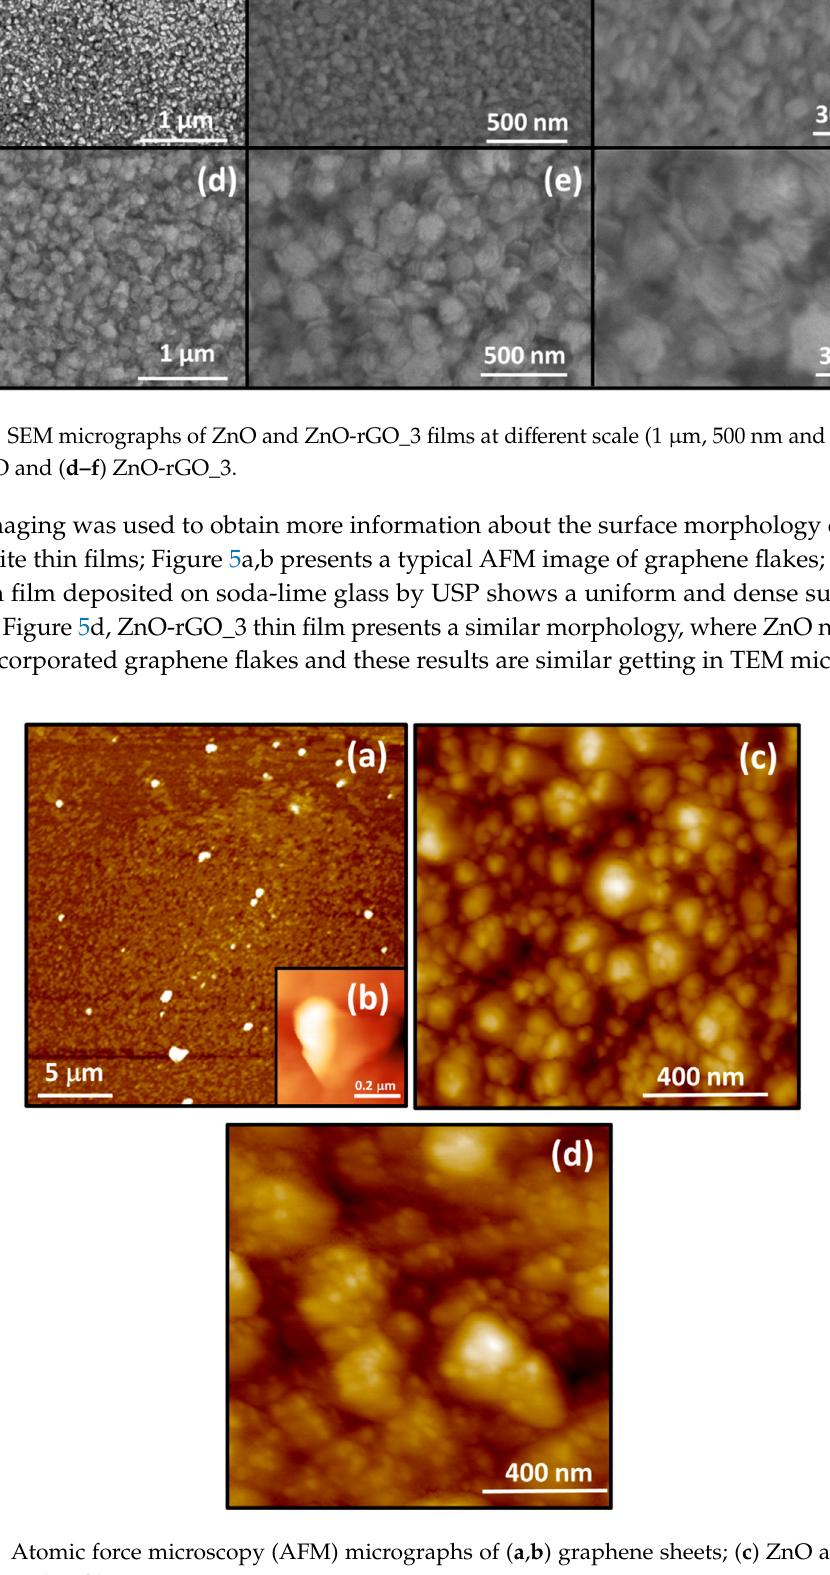
Figure 5. Atomic force microscopy (AFM) micrographs of ( a,b ) graphene sheets; ( c ) ZnO and ( d ) a ZnO-rGO_3 thin film. ZnO-rGO_3 thin